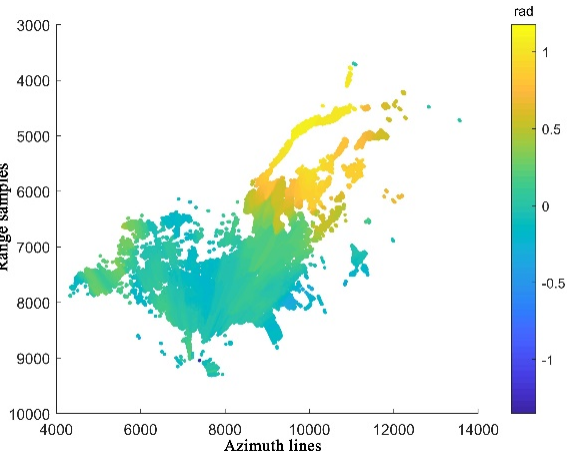
Fig 18 . Residual phase diagram after unwrapping. The interference phase contains only a small amount of deformation phase and atmospheric phase, so it is easier to untangle and reduce the unwinding error.